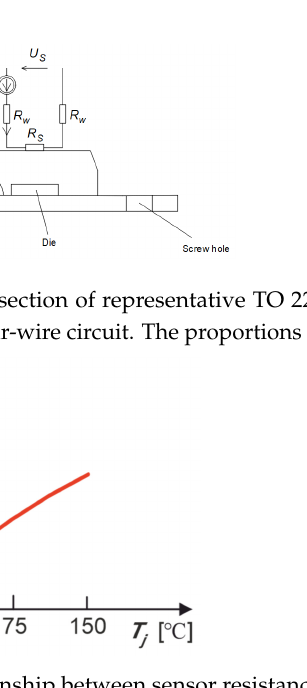
Figure 12. Relationship between sensor resistance R S and case temperature T C of a semiconductor device whose temperature is measured.